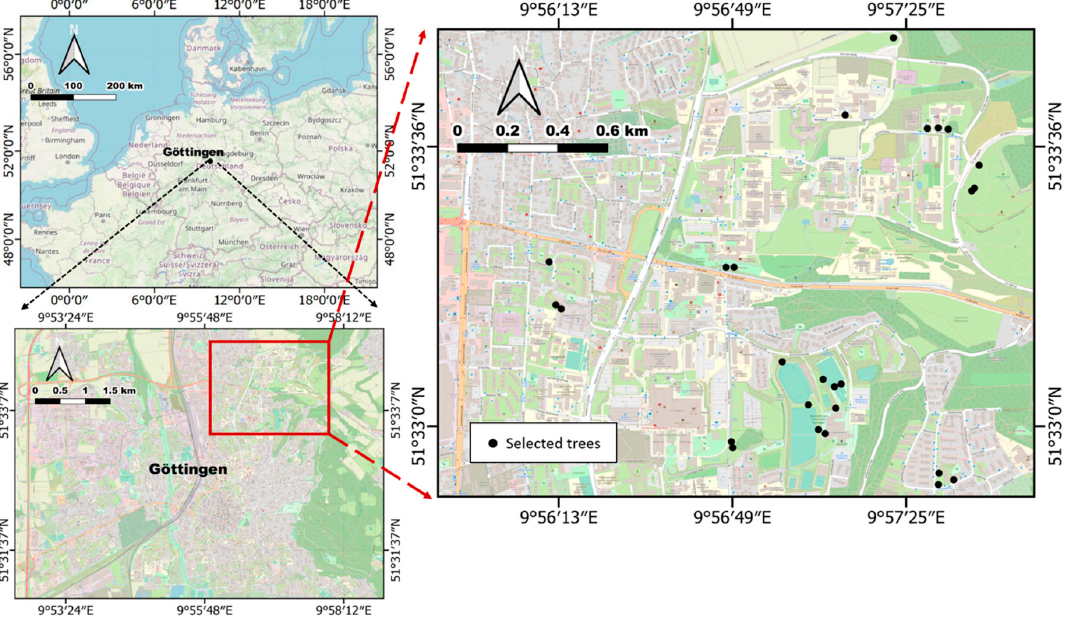
Figure 1. Study area and the locations of the selected trees (map source: © OpenStreetMap contributors).